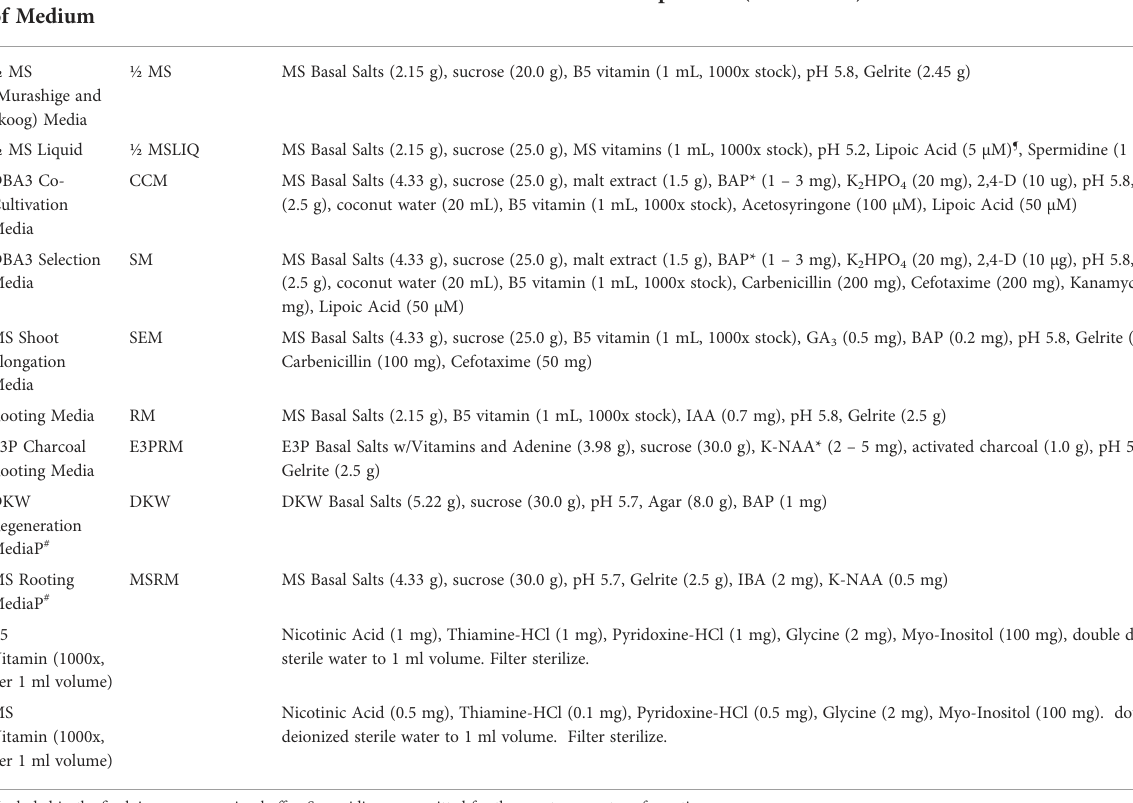
TABLE 1 List of media used for Agrobacterium- based citrus